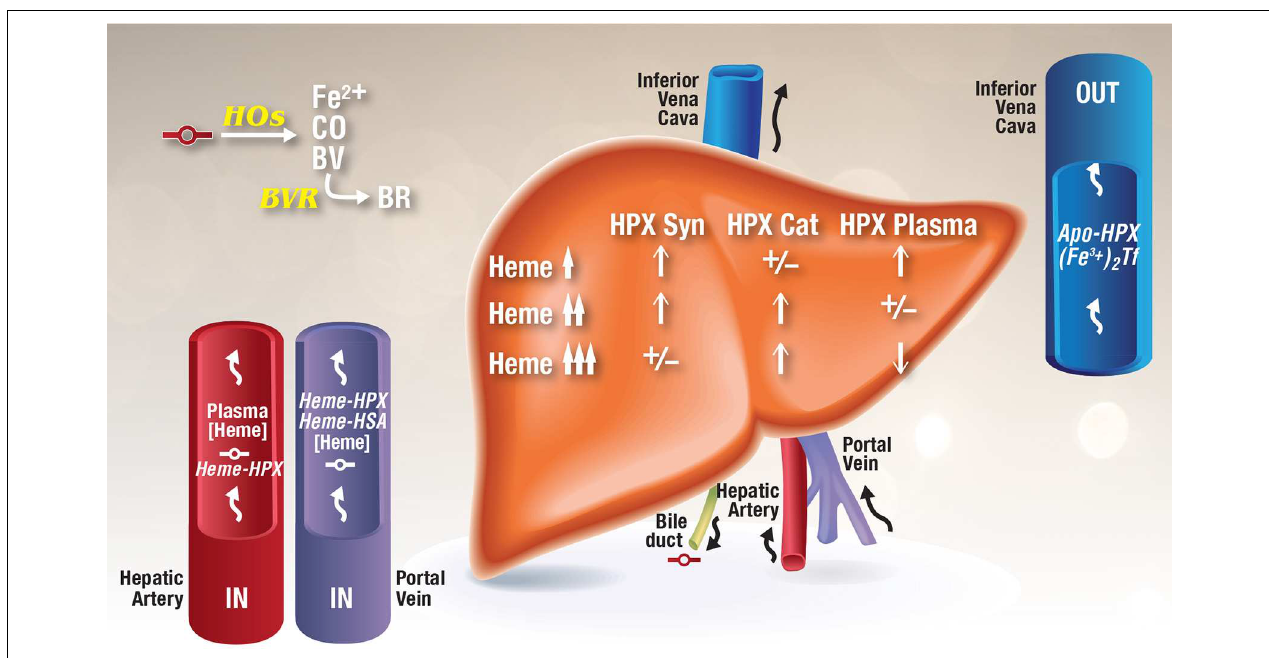
FIGURE 1 | Model for the development of HPX depletion states. This model is based on data from rhesus monkeys given heme i.v. (Foidart et al., 1982 ), HPX metabolism studies in humans (Foidart et al., 1983), known induction of HPX by heme (Smith, 1999; He et al., 2010), normal recycling of HPX after heme delivery ( Smith and Morgan, 1978, 1979), and HPX catabolism after i.v. administration of heme several fold higher than the binding capacity of HPX ( Sears, 1970; Lane et al., 1972). As heme-HPX forms in plasma, uptake of this complex by receptor-mediated endocytosis into liver parenchymal cells raises heme levels. In HPX deficiency states, heme will traffic unregulated into cells. HOs initially